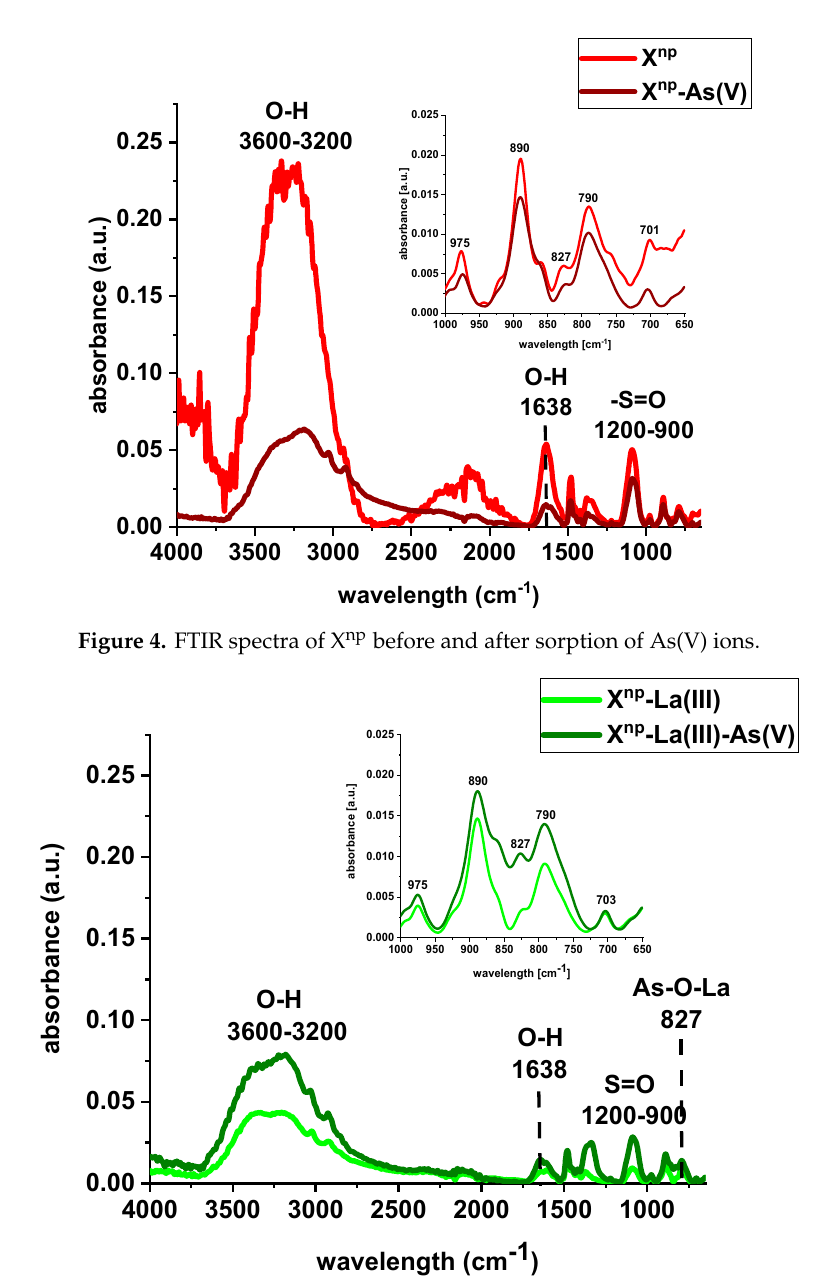
Figure 5. FTIR spectra of X np -La(III) before and after sorption of As(V) ions.